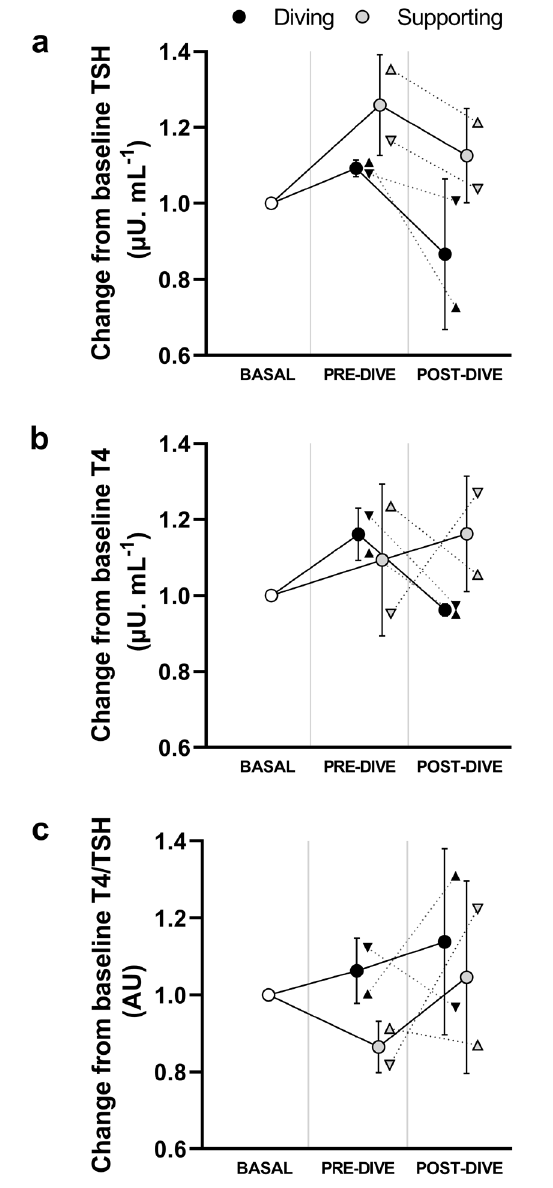
Figure 3. Blood hormonal concentrations measured at three time points: baseline (on the ship, 09:00 h), pre-dive (field, 11:30 h), and post-dive (on the ship, noon) in the two groups (n = 4). a) thyroid-stimulating hormone (TSH). b) thyroxine (T4). c) the T4/TSH ratio. The pre-and post-dive data were normalized to the baseline data, which were set at 1. The data are expressed as means ± SD for the Diving (black circle) and Supporting (grey circle) groups. The dots represent the individual datum of the Diving group - volunteer one ( ▼ ) and volunteer two ( ▲ ) - and the Supporting group - volunteer three ( ▲ ) and volunteer four ( ▼